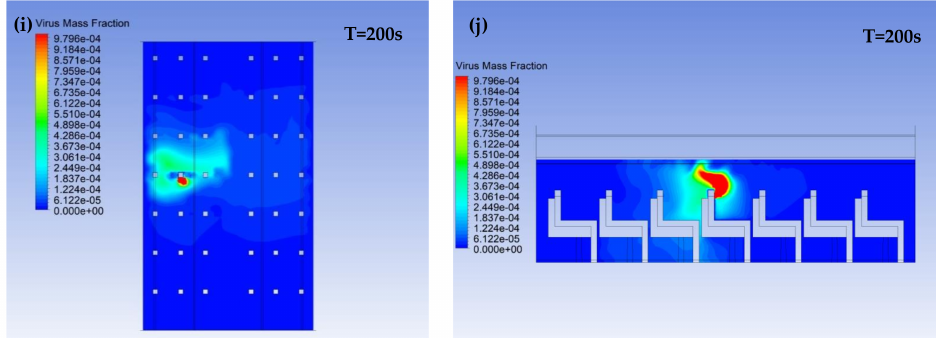
Figure 2. The dynamic propagation process of pathogens 5 s, 50 s, 100 s, 150 s 200 s after the